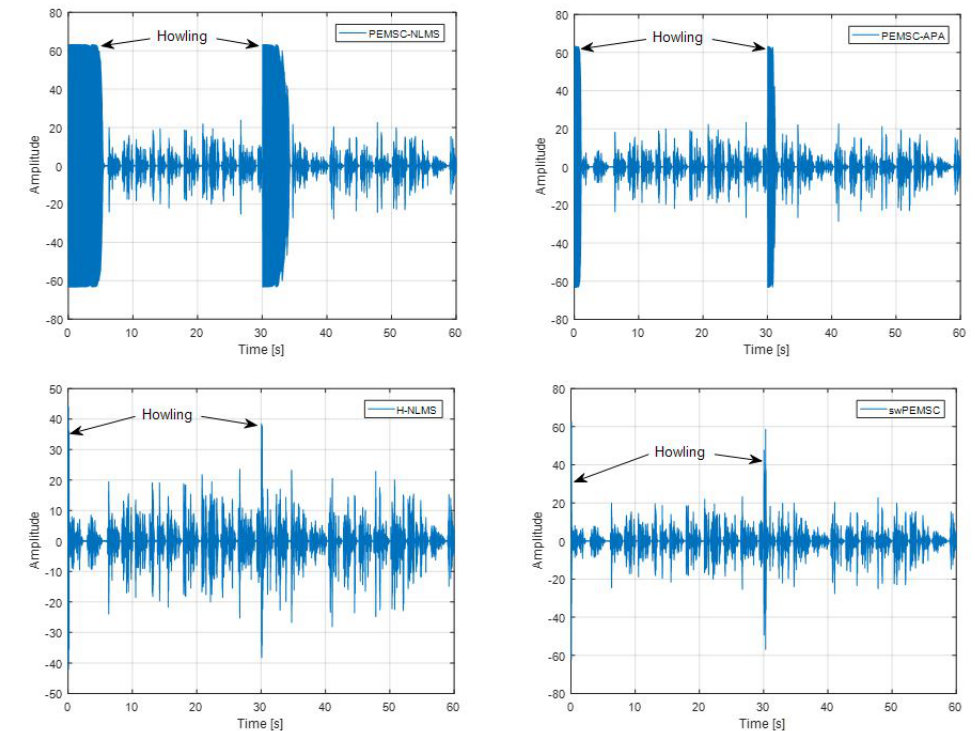
Figure 12. Compare howling periods in output signal of the proposed approach with baselines, speech incoming signal, a sudden change of the feedback path from F 1 to F 2 after 30